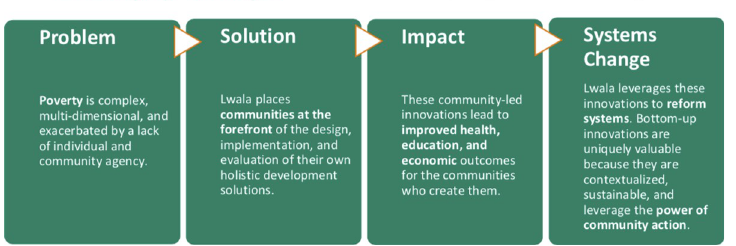
Fig 2. Lwala Community Alliance theory of change. Lwala utilizes a community-led model to improve health, education, and economic outcomes.